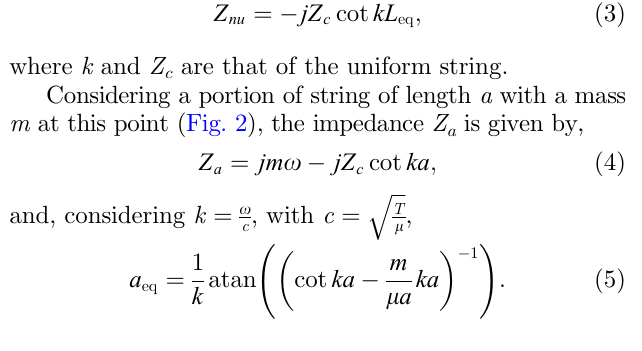
as a function of nf 1